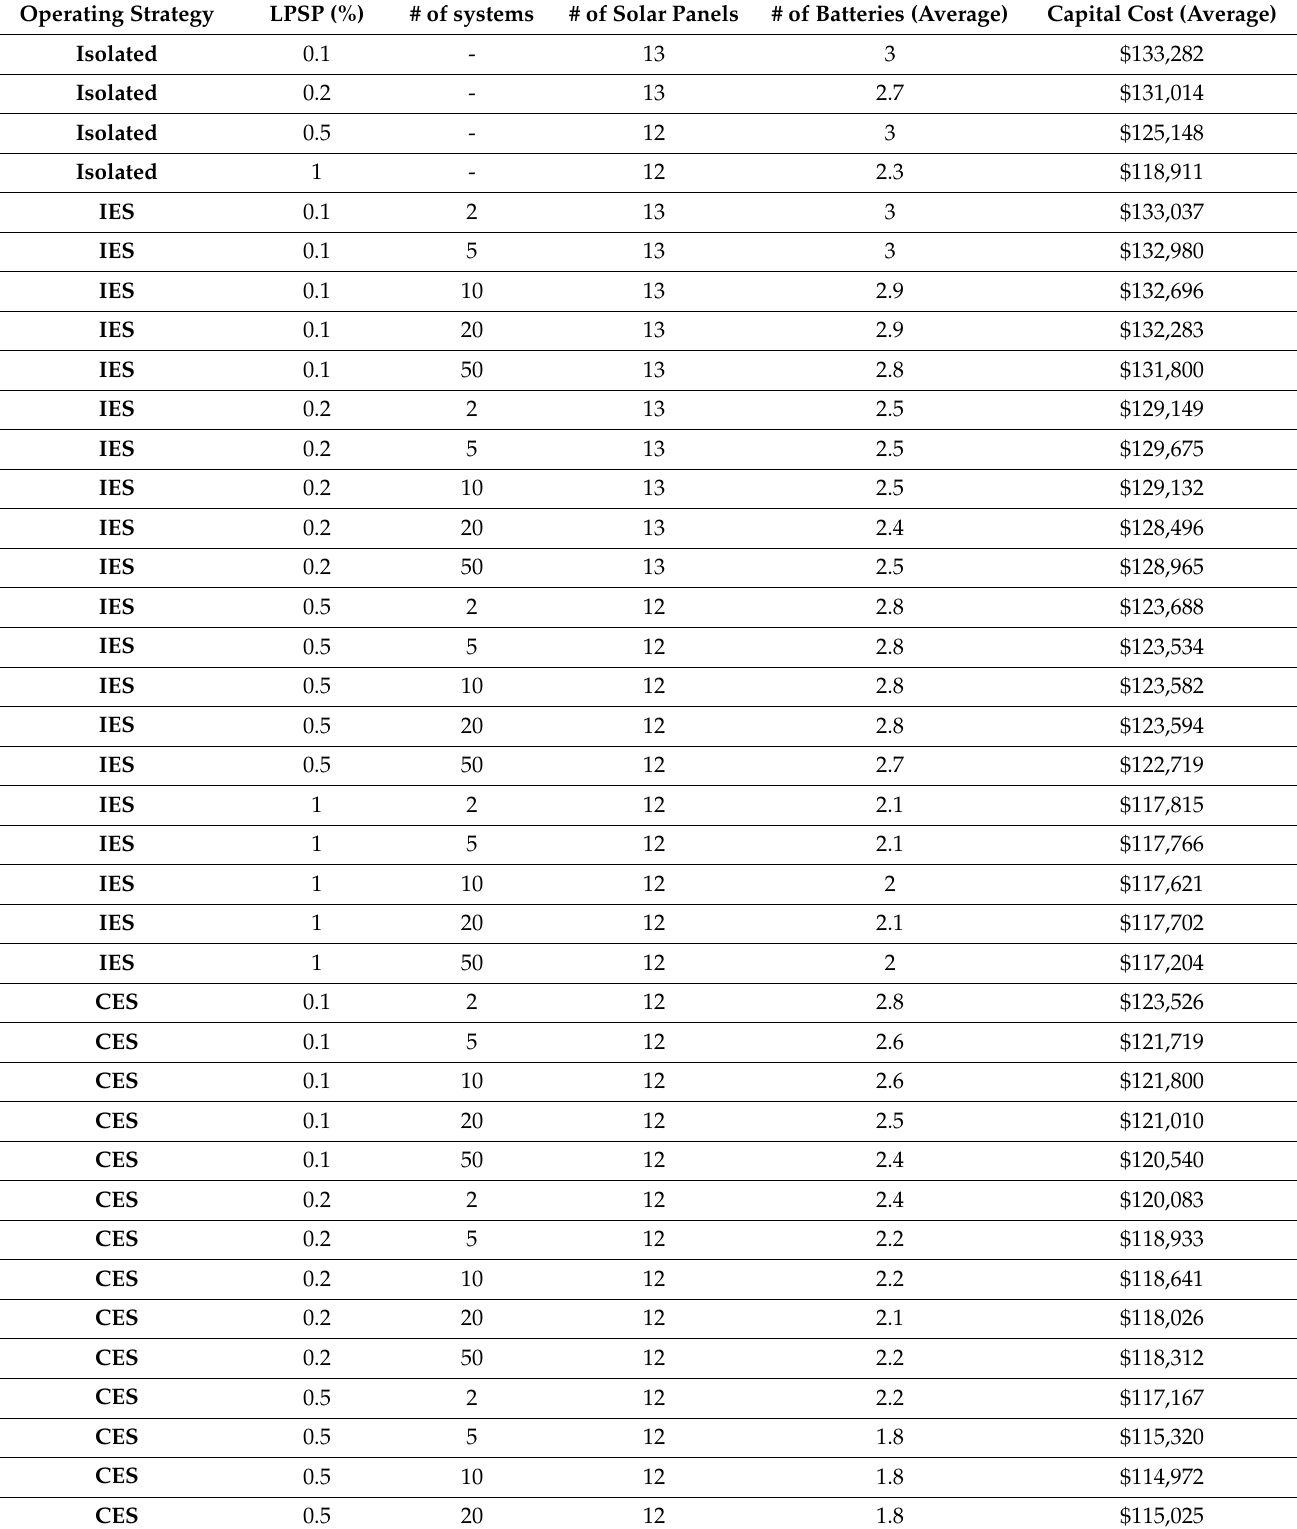
Table A2. Summary table for Erie showing average lowest cost configuration for each